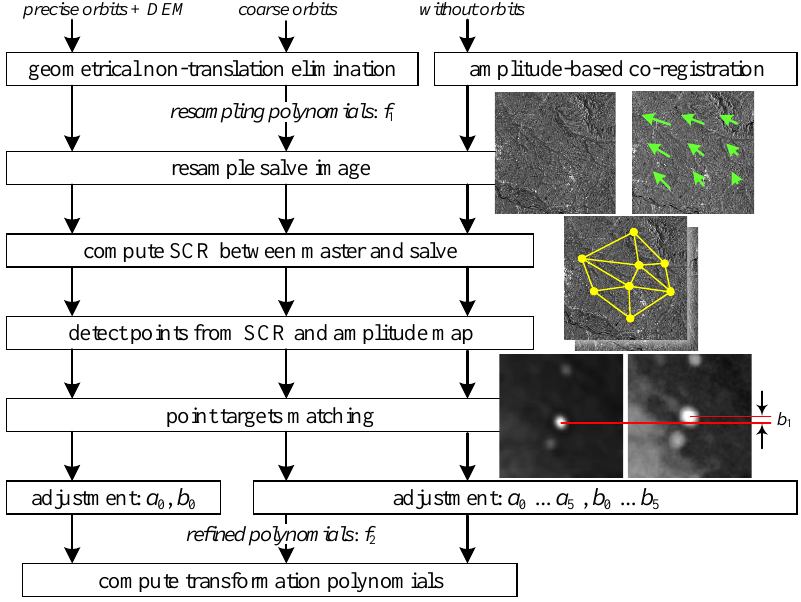
Figure 3. Workflow of the improved co-registration method.